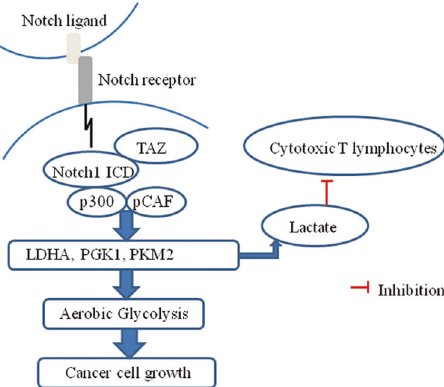
Fig. 7 Schematic diagram illustrating the mechanism of Notch1/ TAZ axis involved in aerobic glycolysis and immune escape in lung cancer. Notch1 forms a positive feedback loop with TAZ and promotes glycolytic gene expressions through interaction with p300 and pCAF. Increased levels of extracellular lactate via Notch1/TAZ loop inhibits cytotoxic T-cell activity, which contributes to lung cancer